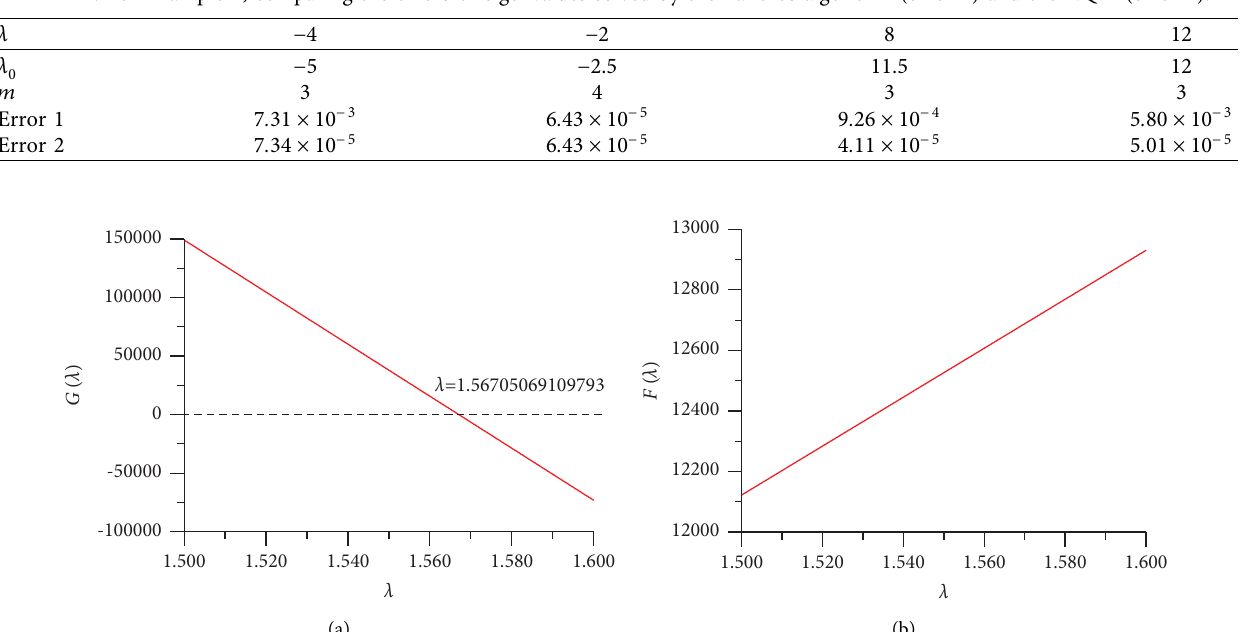
Figure 2: For Example 2, showing four roots of the nonlinear equation obtained from (a) the Rayleigh quotient and (b) the new quotient, corresponding to eigenvalues − 4, − 2, 12, and 8 with m � 3, and − 2, 12, and 8 with m � 2. Table 1: For Example 2, comparing the errors of eigenvalues solved by the Lanczos algorithm (error 1) and the NQM (error 2).